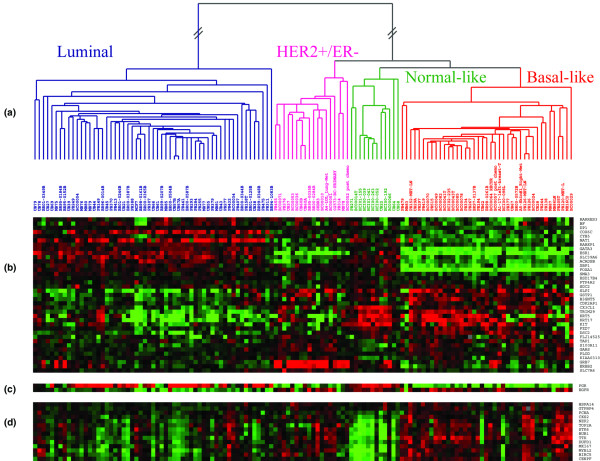
Two-way hierarchical clustering of real-time quantitative reverse-transcription (qRT)-PCR data. (a) The sample-associated dendrogram groups the 126 breast samples profiled by qRT-PCR into the same classes seen by microarray analysis. Samples are grouped into Luminal (blue), HER2+/ER- (pink), Normal-like (green), and Basal-like (red) subtypes. The expression level for each gene is shown relative to the median expression of that gene across all the samples, with high expression represented by red and low expression represented by green. Genes with median expression are black and missing values are gray. (b) A minimal set of 37 'intrinsic' genes was used to classify tumors into their primary 'intrinsic' subtypes. The 'intrinsic' gene set was supplemented using (c) PgR and EGFR, and (d) proliferation genes. The genes in (c) and (d) were clustered separately in order to determine agreement between the minimal 37 qRT-PCR 'intrinsic' set and the larger 402 microarray 'intrinsic' set (see Additional file 1, Supplemental Figure 1). Overall, 114/123 (93%) primary breast samples were classified the same between microarray and qRT-PCR.